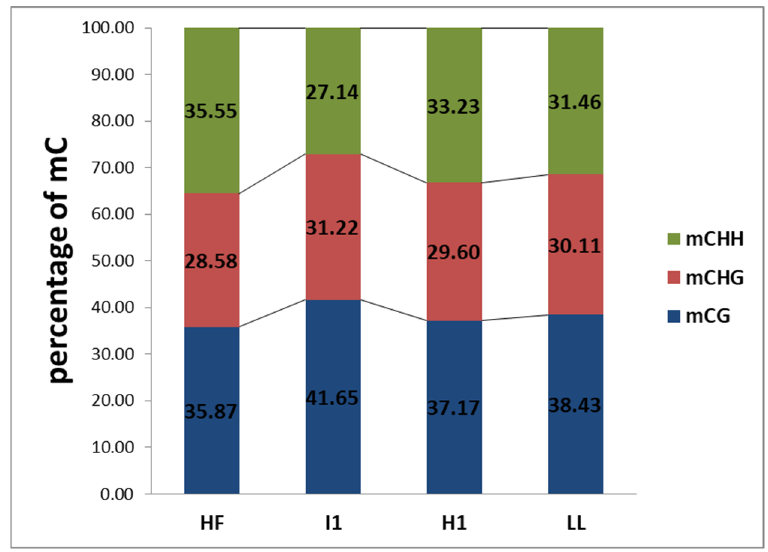
Figure 2. The percentage of Methylcytosines (mCs) in different sequence contexts identified in healthy flowering (HF), phyllody (I1), healthy vegetative (H1) and little leaf (LL) sesame samples.